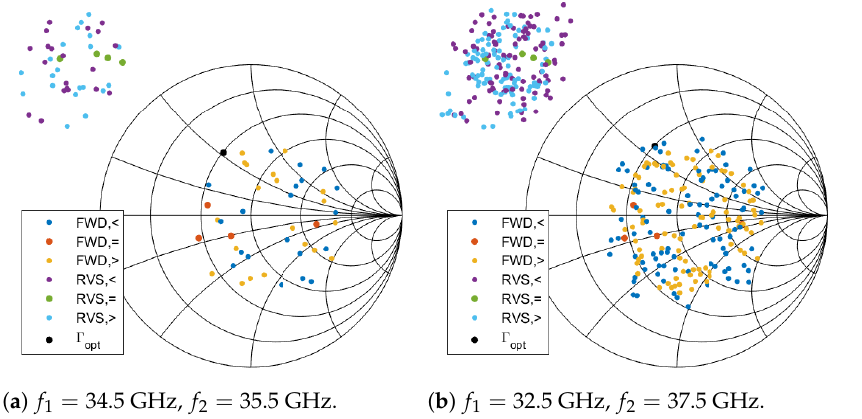
( a ) f 1 = 34.5 GHz, f 2 = 35.5 GHz. Figure 5. Example of termination pattern for the extraction of the noise parameters at f 0 = 35 GHz. The terminations form groups depending whether they are associated with frequencies lower than f 0 (<), equal to f 0 (=) or higher than f 0 (>), and whether they refer to the forward (FWD) or reverse (RVS) mode. In this particular case, the forward mode Γ S reflectances and the reverse mode Γ (cid:48) out reflectances happen to be inside and outside of the passive Smith chart, respectively. The black point represents the optimum point Γ opt